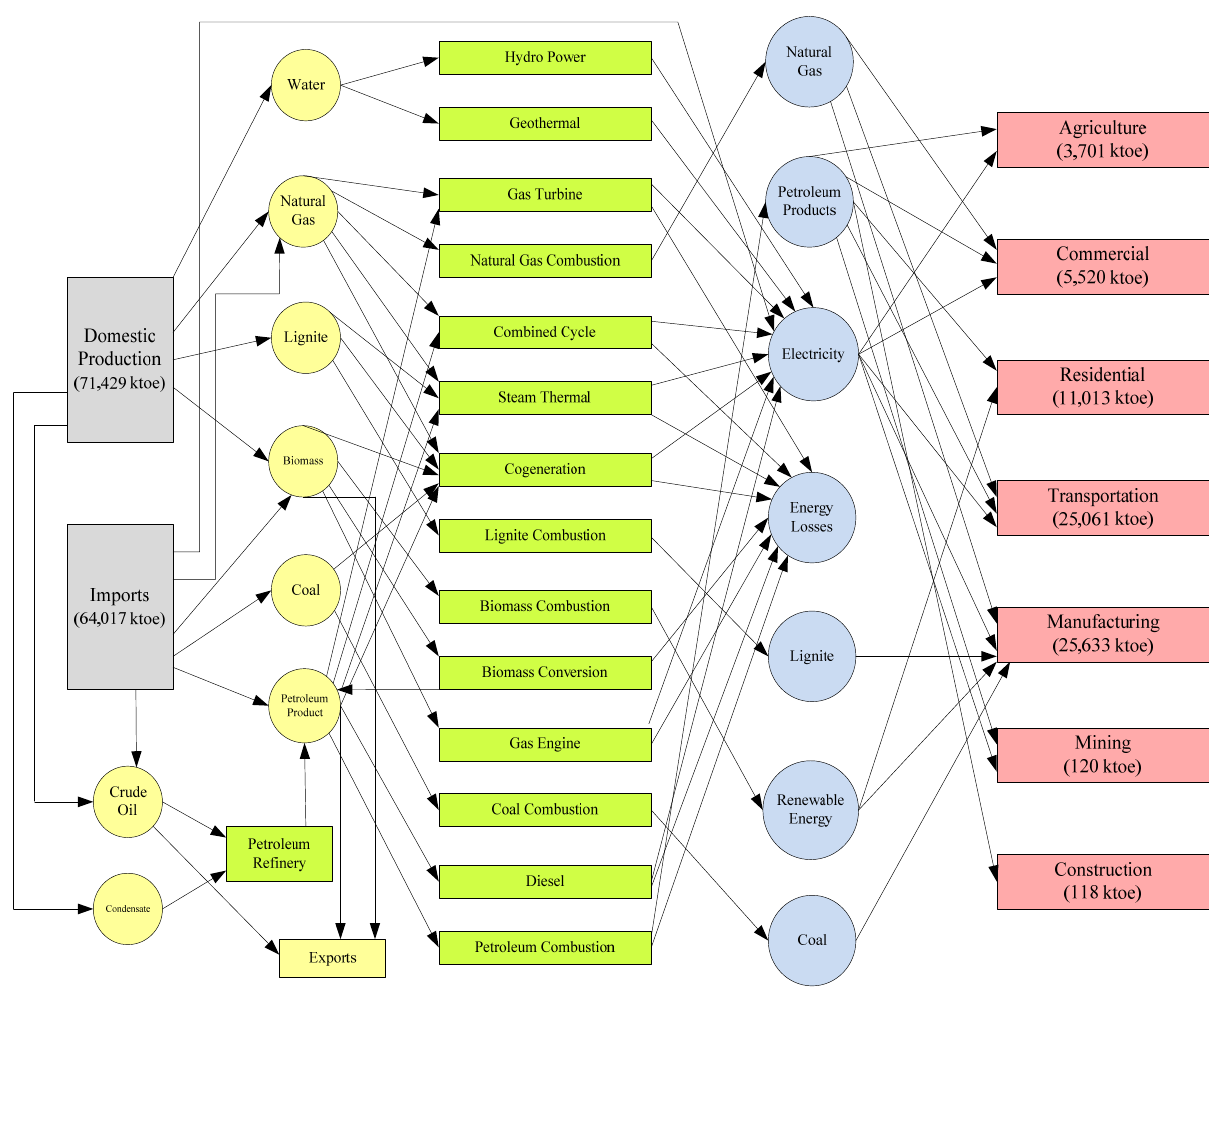
Figure 1. Simplified Thailand RES in 2010 (Source: